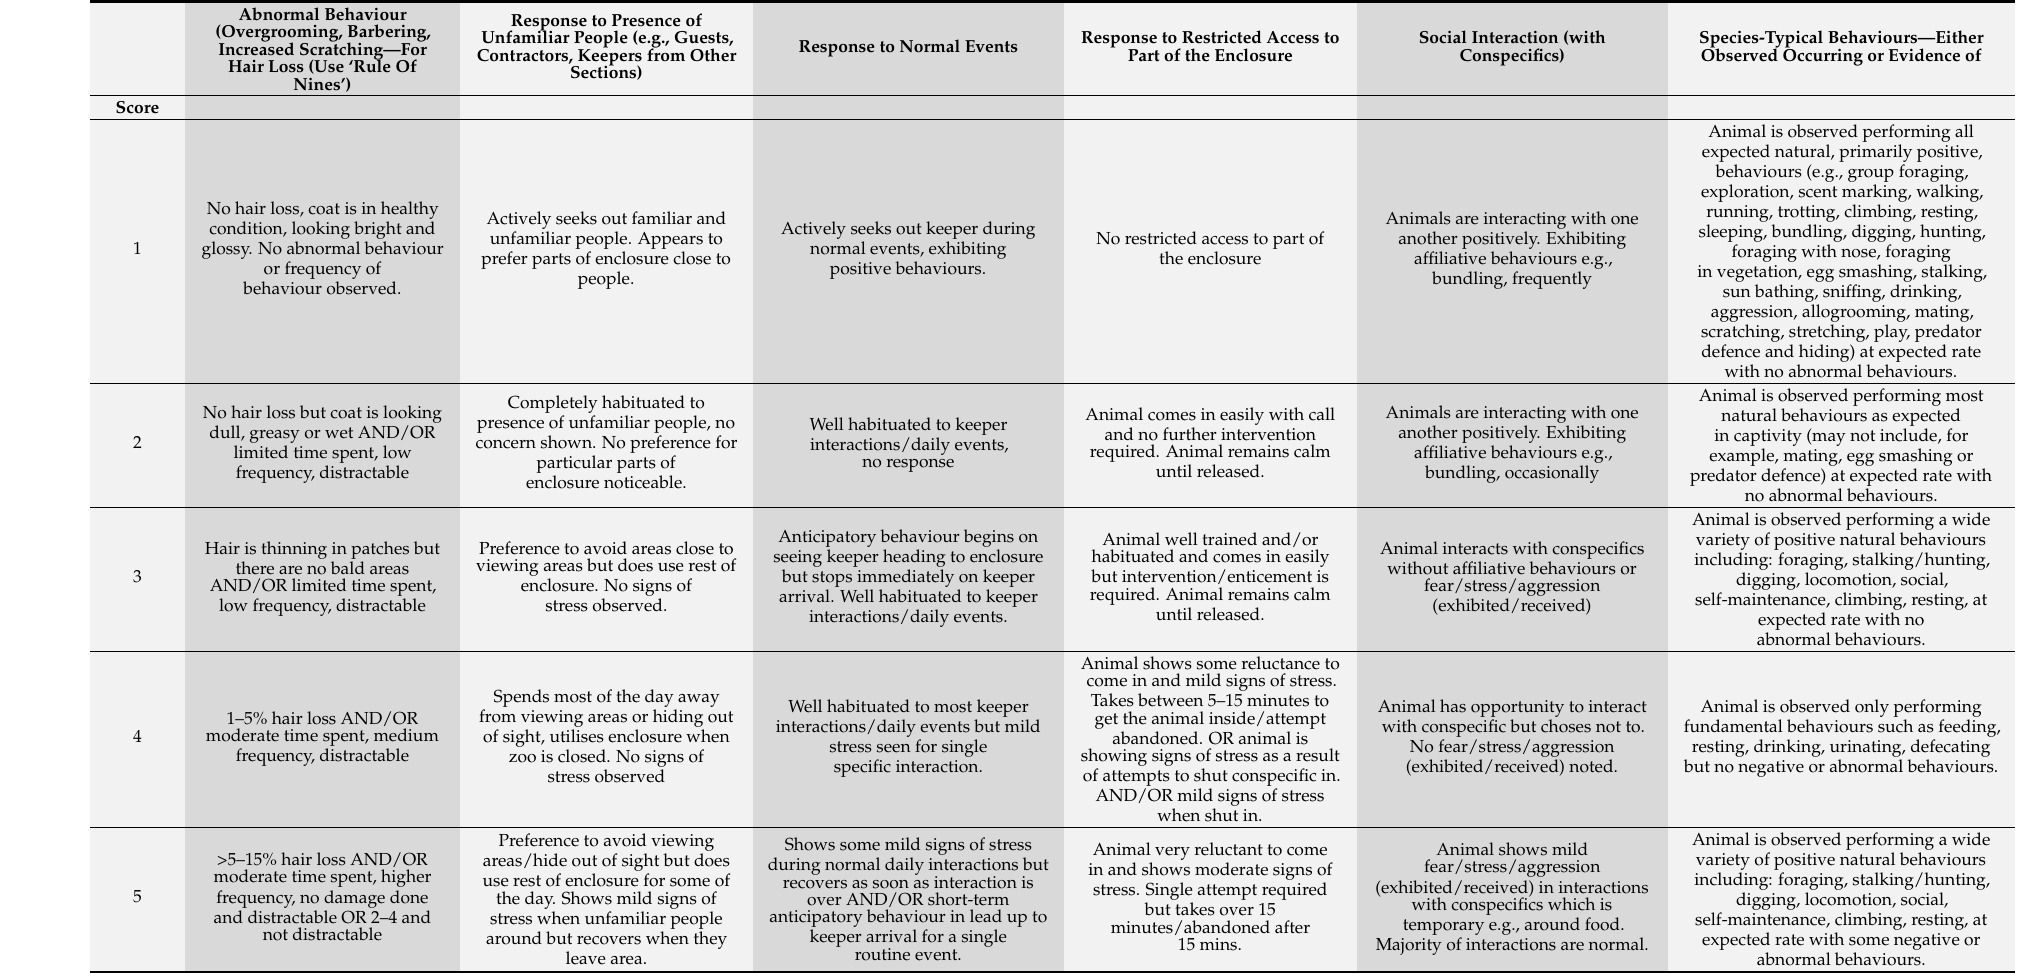
Table 2. Factors scored within the psychological